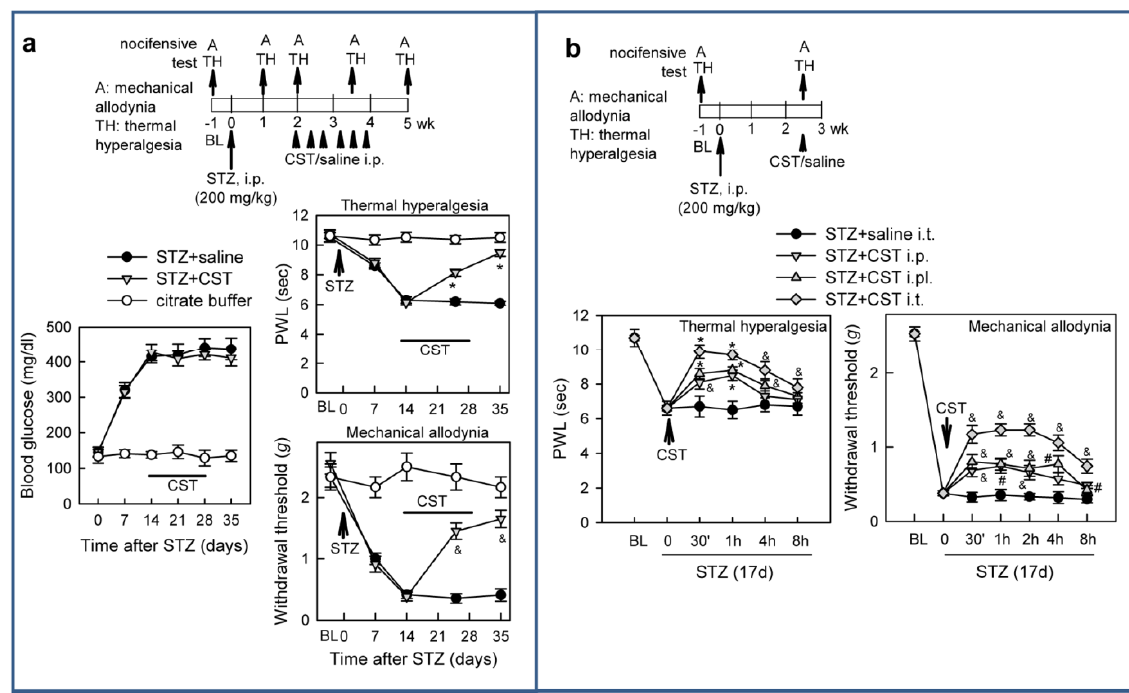
Figure 4. Cortistatin reduced neuropathic pain in diabetic mice. ( a ) Effects of systemic (i.p. 2 µg) cortistatin injection (every other day, for two weeks, as indicated in the scheme) on thermal hyperalgesia represented by paw withdrawal latency (PWL) in response to radiant heat, and on mechanical allodynia represented by the withdrawal threshold (in g) to plantar von Frey hair application in hind paws, before (BL, baseline) or at different times after induction of chronic diabetes by a high dose of streptozotocin (STZ). Nondiabetic mice injected with citrate buffer instead of STZ were used as controls of reference. The course of diabetes was monitored by measuring the glucose levels in blood (left panel). n = 6–8 mice/group. * p < 0.0001, & p < 0.01 vs. saline-treated diabetic mice. ( b ) Effects of a single injection of cortistatin at local (i.pl., 1 µg), systemic (i.p., 2 µg), or central (i.t., 20 ng) levels on thermal hyperalgesia and mechanical allodynia measured 17 days after STZ infusion. n = 8 mice/group. * p < 0.0001, & p < 0.01, # p < 0.05 vs. saline-treated STZ-diabetic mice. All data represents mean ± SEM.